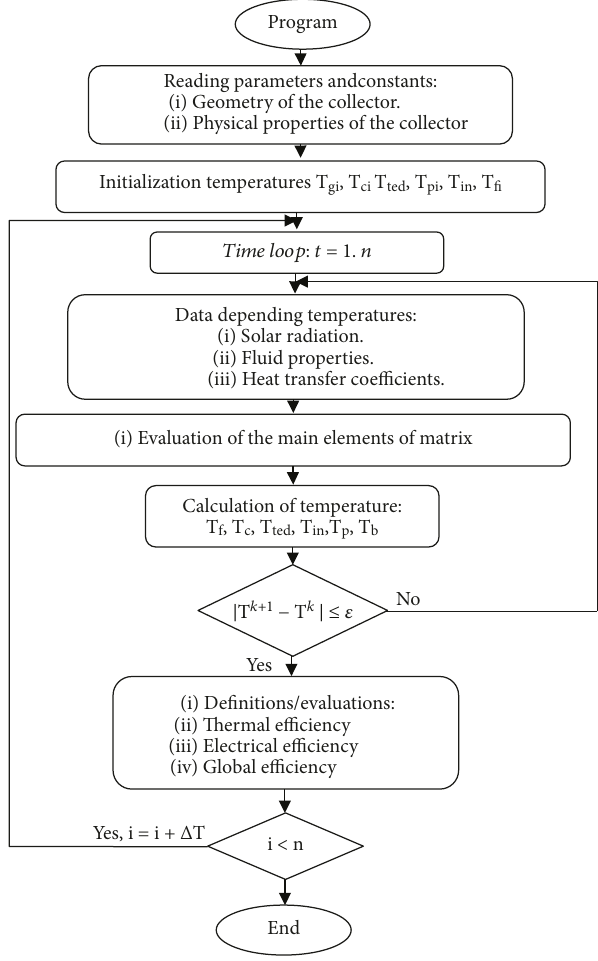
Figure 2: Flowchart for the computer